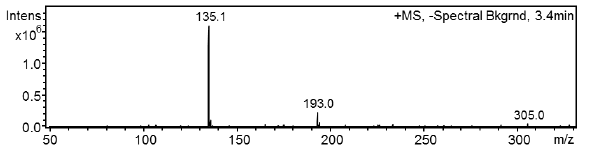
Figure 4. Concentration of BI in 3 M AS at different initial glyoxal concentrations is shown as a function 2 Fig. 4. Concentration of BI in 3 M AS at different initial glyoxal of reaction time. Concentrations were determined via 280 nm absorption band at 3.5 min retention 3 concentrations is shown as a function of reaction time. Concentra- time using HPLC-DAD. 4 tions were determined via 280nm absorption band at 3.5min reten- tion time using HPLC-DAD. Table 2. Initial production rates of BI (R BI ) depending on initial Gly